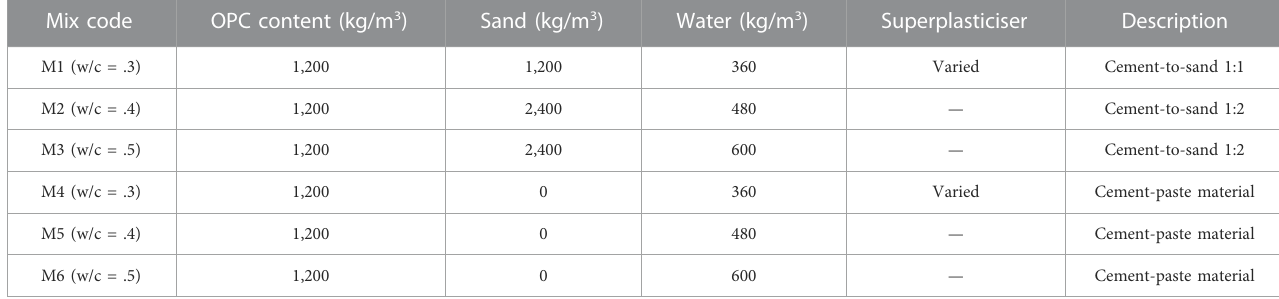
TABLE 3 Mass proportions of mixes used.